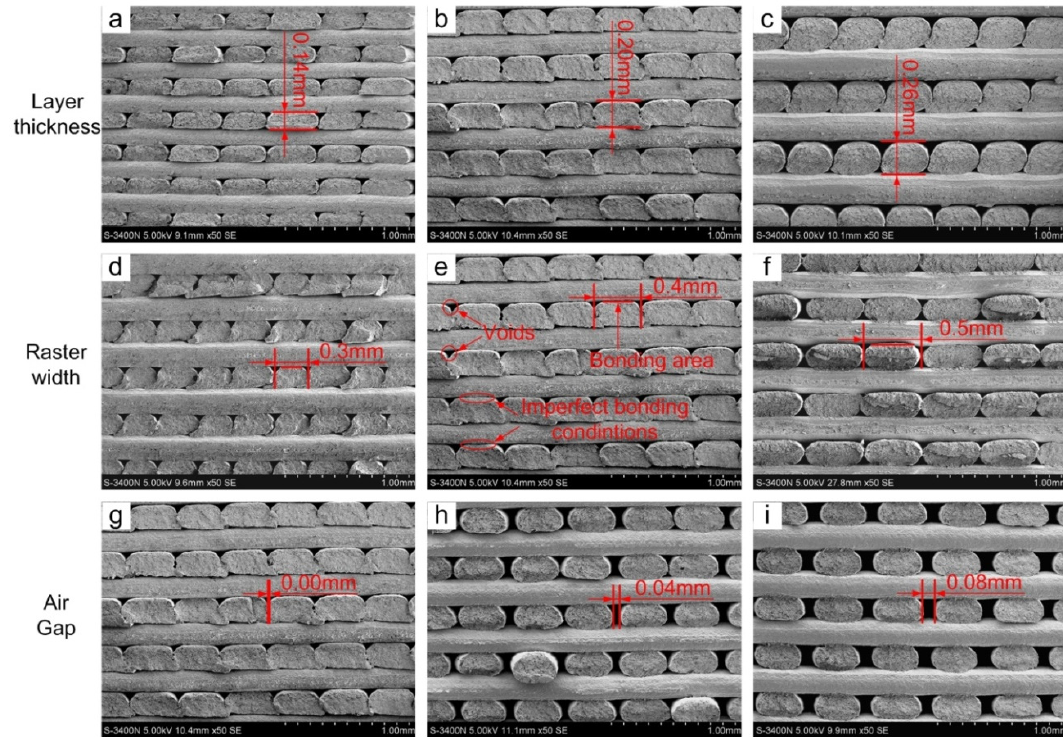
Figure 4. SEM images of the internal structure of 3D ‐ printed parts for different parameter values.